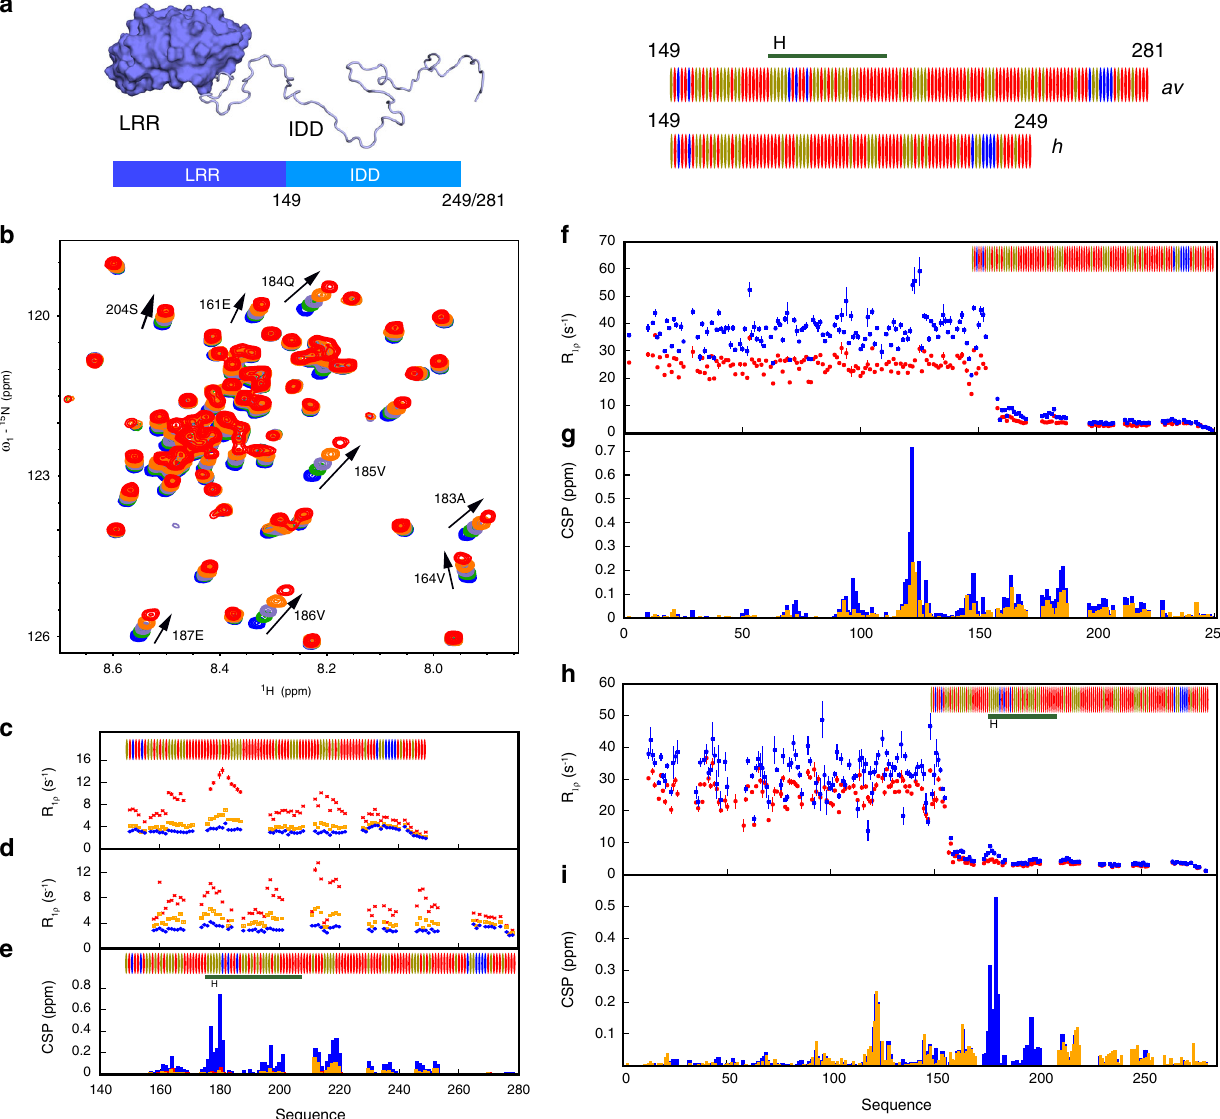
Fig. 1 NMR of ANP32A with 627-NLS reveals a highly dynamic polyvalent complex. a Representation of the domains of ANP32A. Blue surface shows the LRR domain, pale blue ribbon-disordered IDD (100 or 132 amino acids). Sequence distribution of IDDs shown on right. Red = acidic, blue = basic and beige = hydrophobic or polar. Av IDD contains a 33 amino acids insert (horizontal line) comprising an avian-unique hexapeptide (H). b Chemical shift titration of 627(K) into 15 N-labelled IDD of h ANP32A. h ANP32A was 25 μ M throughout. 627(K) concentrations were 0 (blue), 25 (green), 50 (grey-blue), 100 (orange) and 200 (red) μ M. Measurement at 850 MHz, 293 K (see ‘ Methods ’ section). c 15 N rotating frame relaxation ( R 1 ρ ) of free (blue) 15 N-labelled IDD of h ANP32A at 300 μ M, and upon mixing with 627(K) at 1:1 (orange) and 1:4 (red) ratio. Measurement at 850 MHz, 293 K. d 15 N rotating frame relaxation ( R 1 ρ ) of free (blue) 15 N-labelled IDD of av ANP32A at 300 μ M, and upon mixing with 627(E) at 1:1 (orange) and 1:4 (red) ratio. Maximum effect is seen at the equivalent motif, 33 amino acids downstream, from h ANP32A. e Chemical shift perturbation (CSP) of full-length av ANP32A upon addition of 627(E) (orange), NLS (red) and 627-NLS(E) (blue). Concentration of av ANP32A was 25 μ M and the partner 50 μ M throughout. Resonances from the LRR were not observable at this low concentration. f 15 N rotating frame relaxation (R 1 ρ ) of free (red) 15 N-labelled full-length h ANP32A at 300 μ M, and upon mixing with 627-NLS(K) at 1:1 ratio (blue). Measurement at 850 MHz, 293 K. g CSP of full-length h ANP32A upon addition of 627-NLS(K) (blue). Concentration of h ANP32A was 300 μ M and 627-NLS(K) 600 μ M. The cross-interaction between h ANP32A and 627-NLS(E) is shown for comparison at the same stoichiometric ratio (orange). h 15 N rotating frame relaxation ( R 1 ρ ) of free (red) 15 N-labelled full-length av ANP32A at 300 μ M, and upon mixing with 627-NLS(E) at 1:1 ratio (blue). Measurement at 850 MHz, 293 K. i CSP of full-length av ANP32A upon addition of 627-NLS(E) (blue). Concentration of av ANP32A was 300 μ M and 627-NLS(E) 600 μ M. The cross-interaction between h ANP32A and 627-NLS(E) is shown for comparison at the same stoichiometric ratio (orange). The avian-speci fi c insert is highlighted by shifting data from h ANP32A from residues following the beginning of the insert by 33 amino